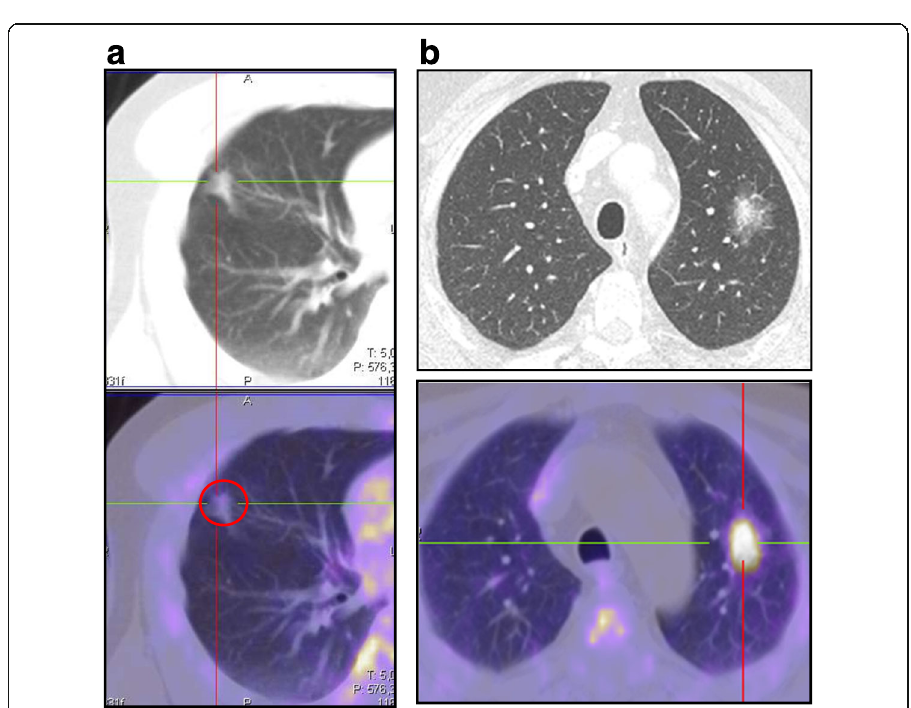
Fig. 4 Examples of PET/CT imaging. ( a ) A 75 year-old man with a previous history of colon-rectal cancer. A CT imaging showed a sub-solid lung nodule (diameter of pars-solid was 9 mm). FDG PET/ CT was negative. After 18 months of follow-up, the nodules disappeared. ( b ) A 72 year-old man with a previous prostate cancer treated with hormonal therapy from 2007. In 2010, CT imaging revealed a sub-solid lung nodule. PET/CT demonstrated a significant uptake of FDG in the solid component of the nodule. The histopathological analysis was definitive for a lung adenocarcinoma